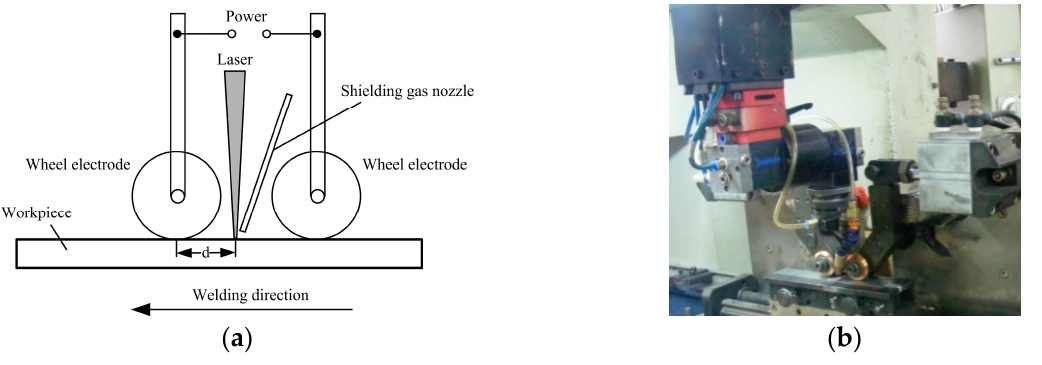
Figure 1. ( a ) Schematic diagram of extra pulse current aided laser welding; ( b ) experimental system.